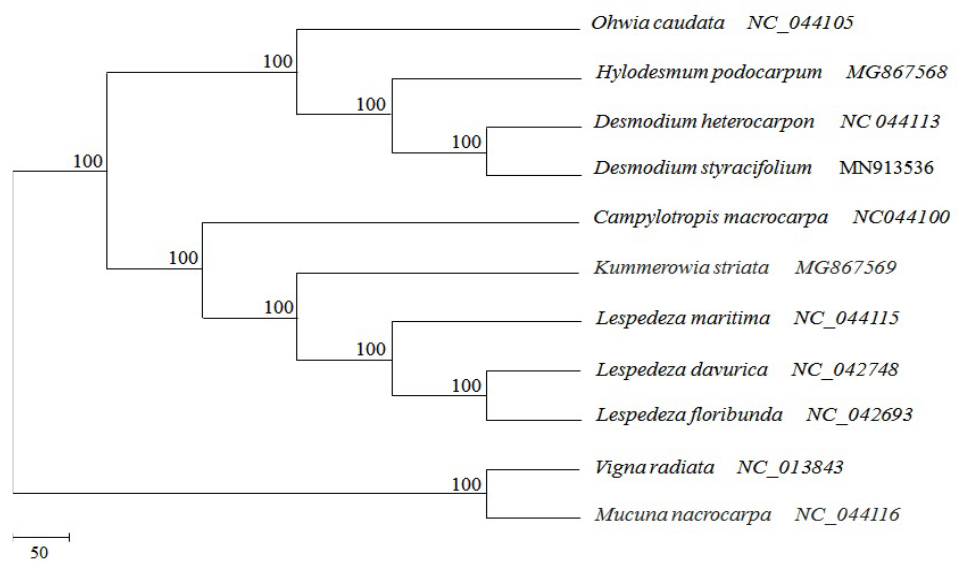
Figure 7. Maximum-likelihood phylogenetic tree reconstruction based on the complete chloroplast genome of eleven genome of eleven species .